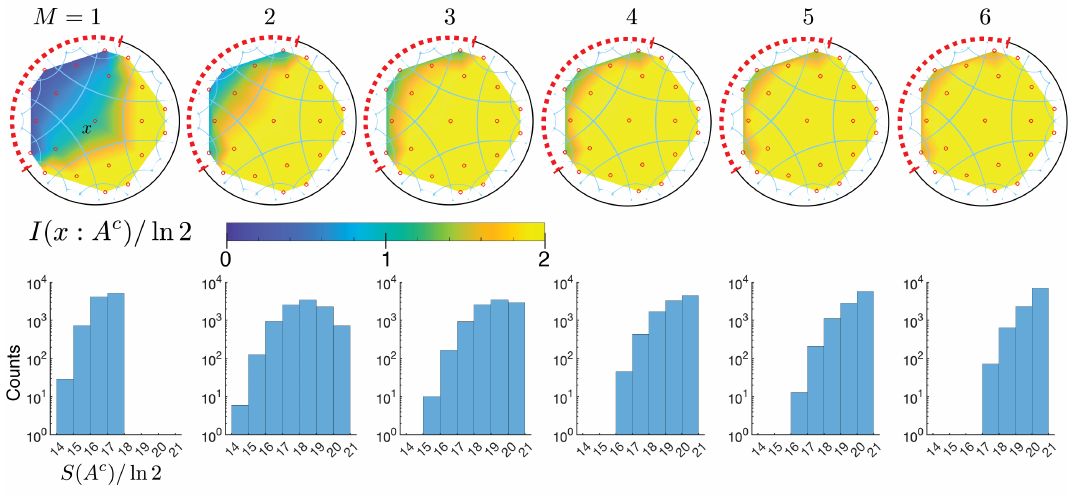
Figure 19 . Brane tension T versus stack depth M . Top row: mutual information I ( x : A c ) between individual bulk qubits x and the remaining boundary A c , averaged over 10 4 random product-state measurement bases on the continuous region A with | A | = 24 . Our results suggest that the brane tension T tends to increase with the stack depth M . Bottom row: distribution of brane tensions, as measured by the entropy S ( A c ) of the remaining boundary qubits A c , sampled over 10 4 random product-state measurement